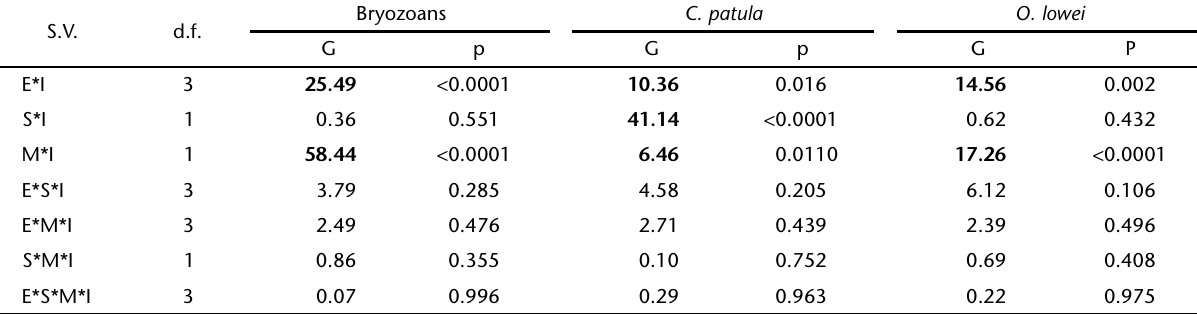
Table II. Arenaeus cribrarius . Significance of the Source of Variation (S.V.) of the log-linear models for the prevalence of infestation (I; present or absent) from the specimens collected in Ubatuba, São Paulo, from May/1991 to April/1993. (E) Season: spring, summer, fall, winter; (S) sex: males and non-ovigerous females; (M) maturity: juveniles and adults.